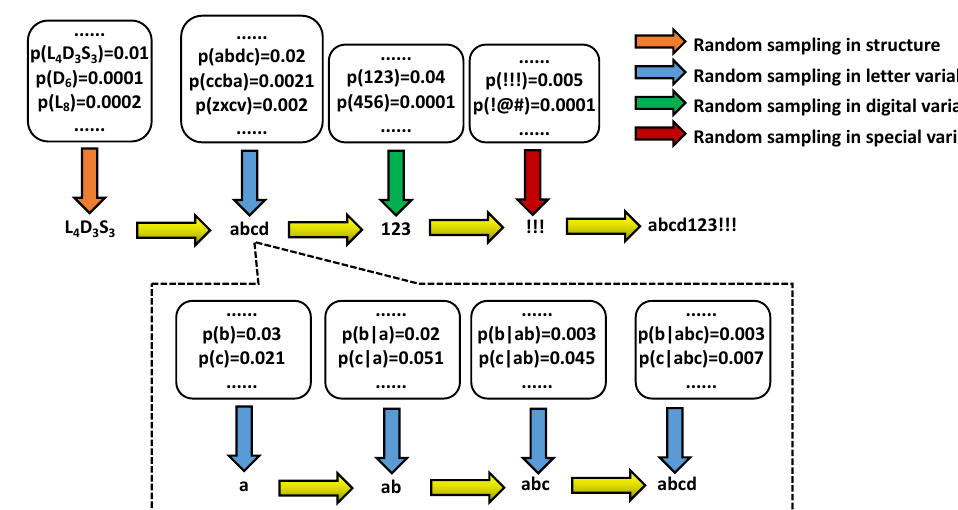
Figure 5. Schematic diagram of LPG–PCFG model generation